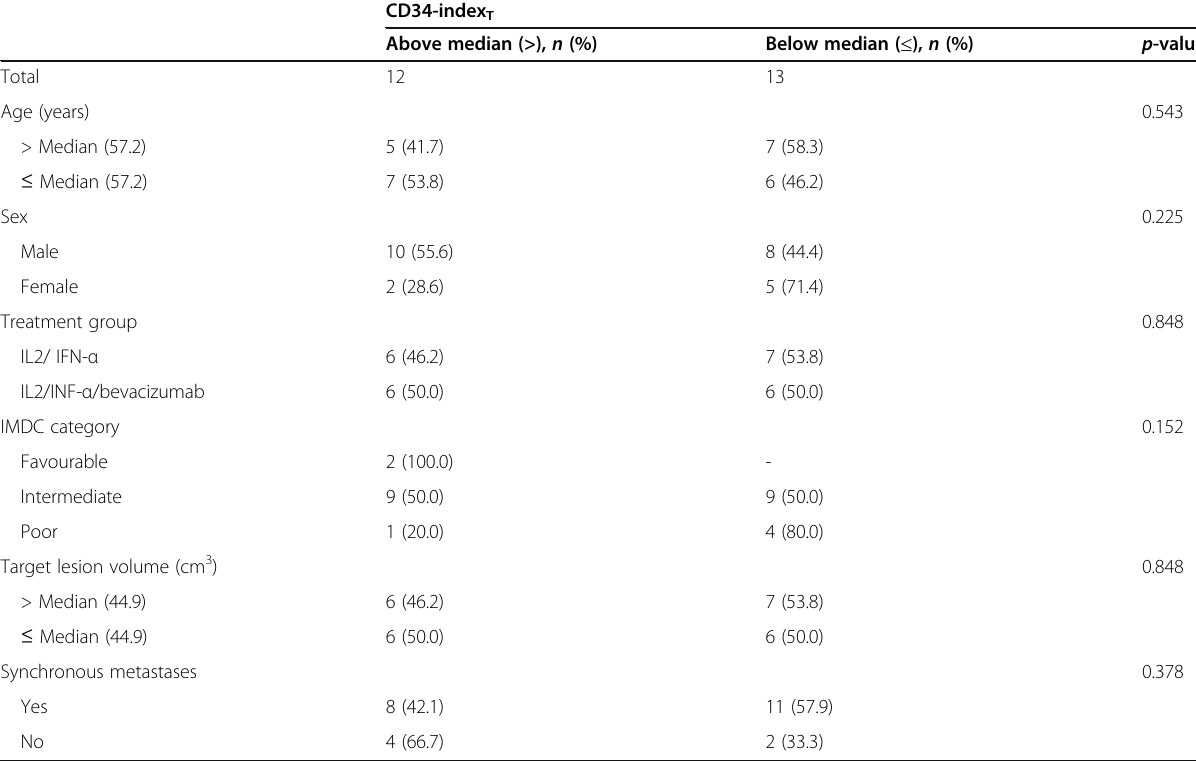
Table 2 Baseline patient characteristics